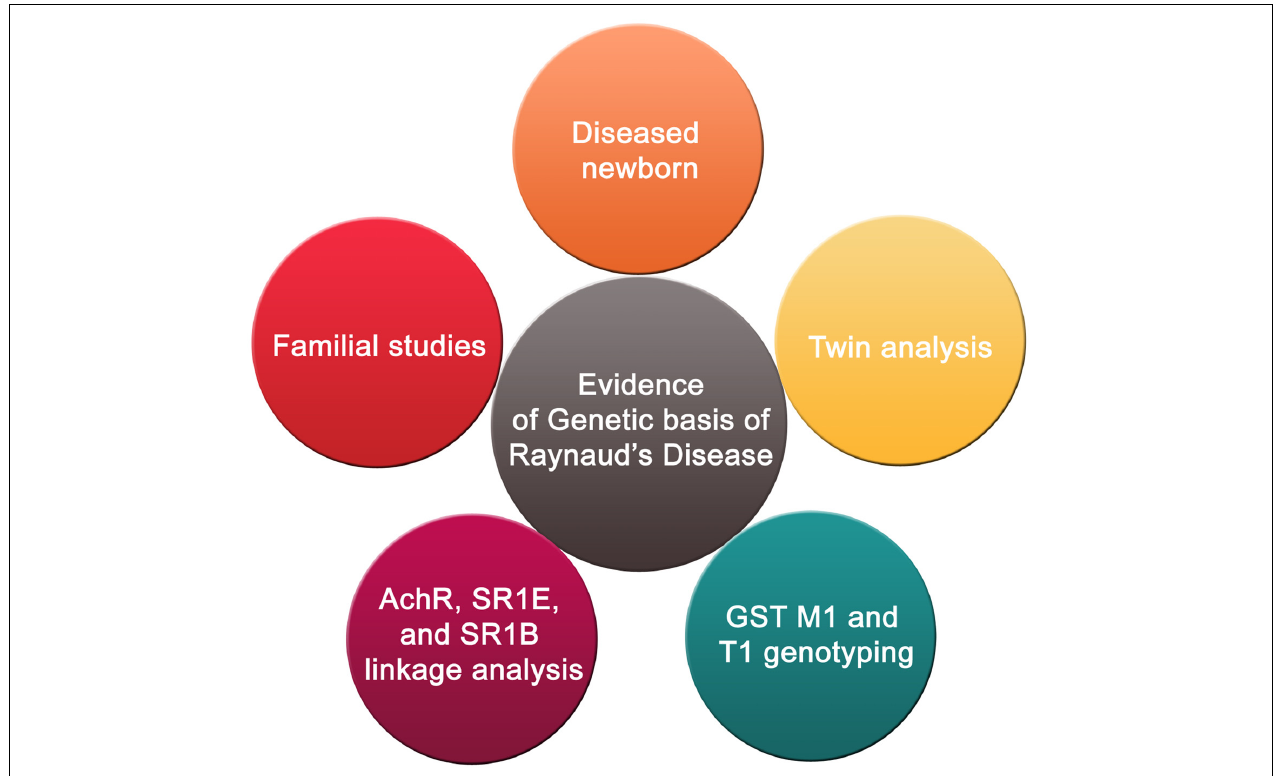
FIGURE 3 | Genetic basis of RP. The genetic basis of RP is supported by familial studies and twin analysis in addition to a reported case of a 1-month male baby diagnosed with the disease. Furthermore, a combination of positive genotypes for both genes encoding glutathione S -transferase M1 and T1 subtypes may have a role in susceptibility to RP. Linkage analysis pinpointed five areas corresponding to three candidate genes ( β -subunit of muscle acetylcholine receptor, 1E and 1B serotonin receptors) which could be associated to